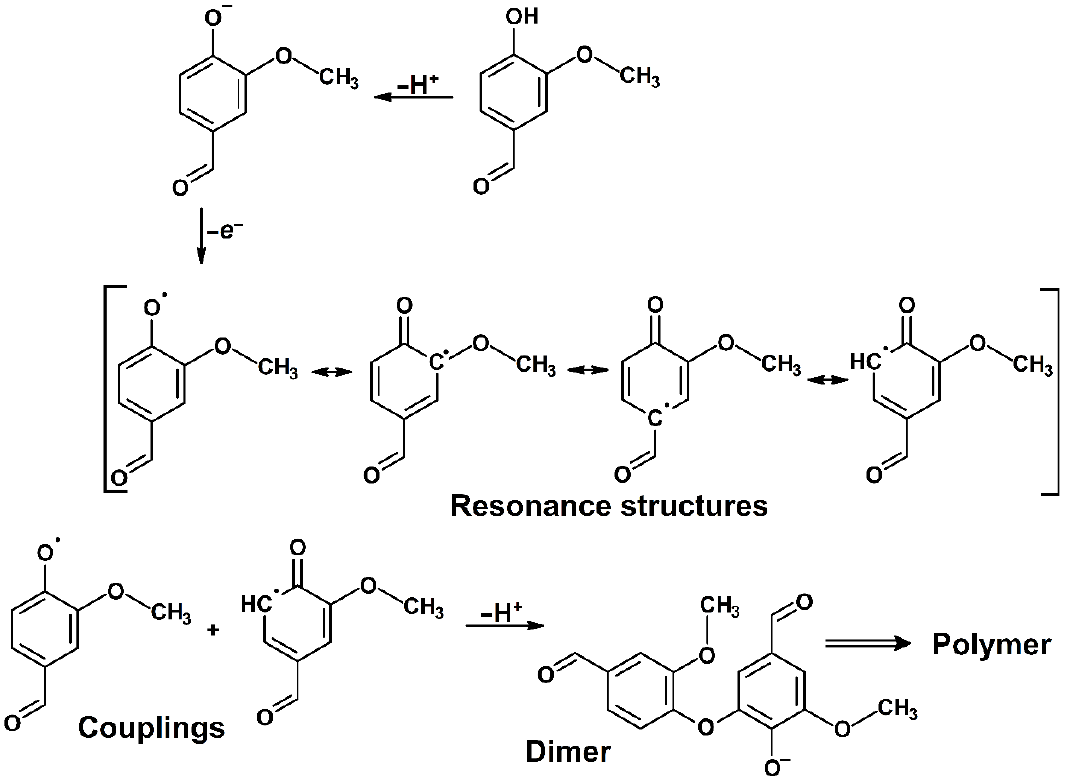
Figure 2. Proposed reaction mechanism of electropolymerization of vanillin.